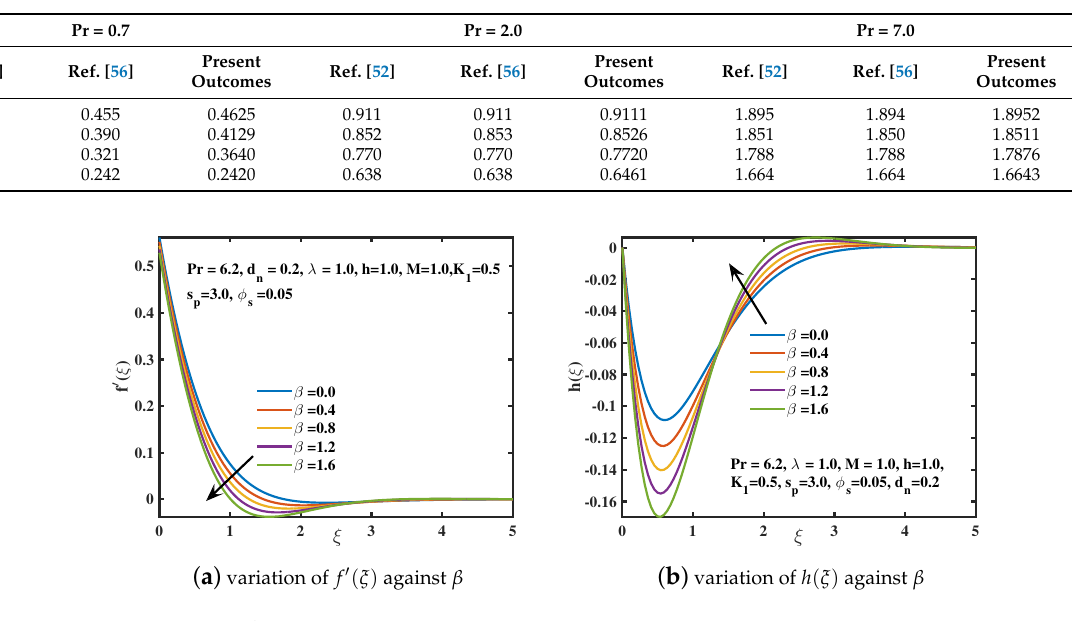
Figure 3. The f (cid:48) ( ξ ) and h ( ξ ) curves for distinct Deborah number ( β ) values.